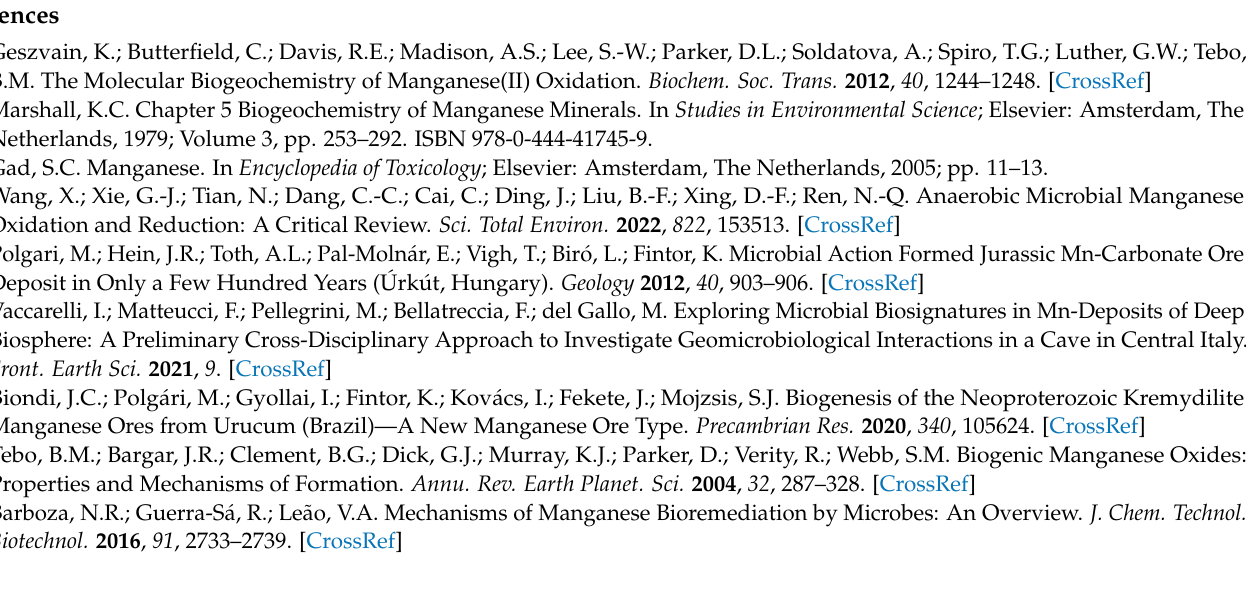
Figure S2. Venn diagram underlining the common ASVs (given in brackets) at the family level. Figure S3. Heatmap of the main genera found in the samples. Figure S4. Summary of the exper- iment setup during Mn-oxide-solubilizing process. Figure S5. Mn-oxide-solubilizing isolates on MMB